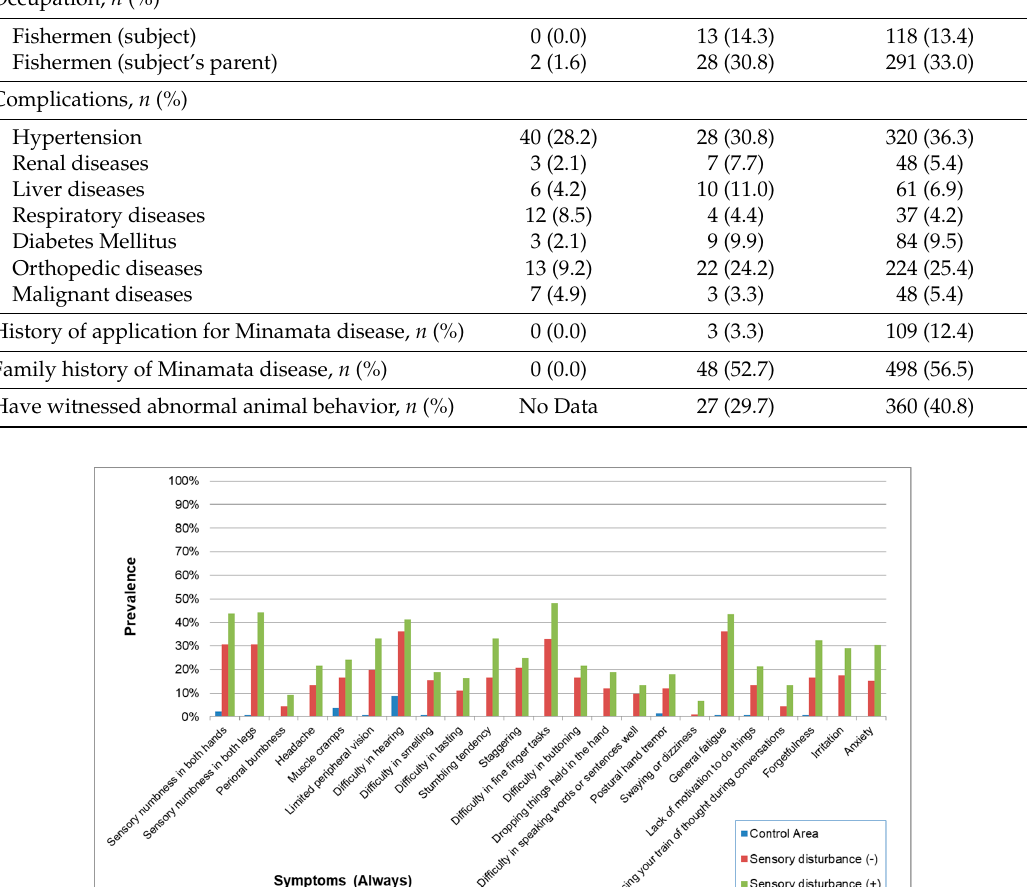
Figure 16. Prevalence of symptoms (Always and Sometimes) in subjects with and without sensory disturbance. The prevalence of symptoms was a little lower in subjects without sensory disturbance than in subjects with sensory disturbance but was apparently higher than the Control Area. The prevalence patterns were similar in exposed subjects with and without sensory disturbance.